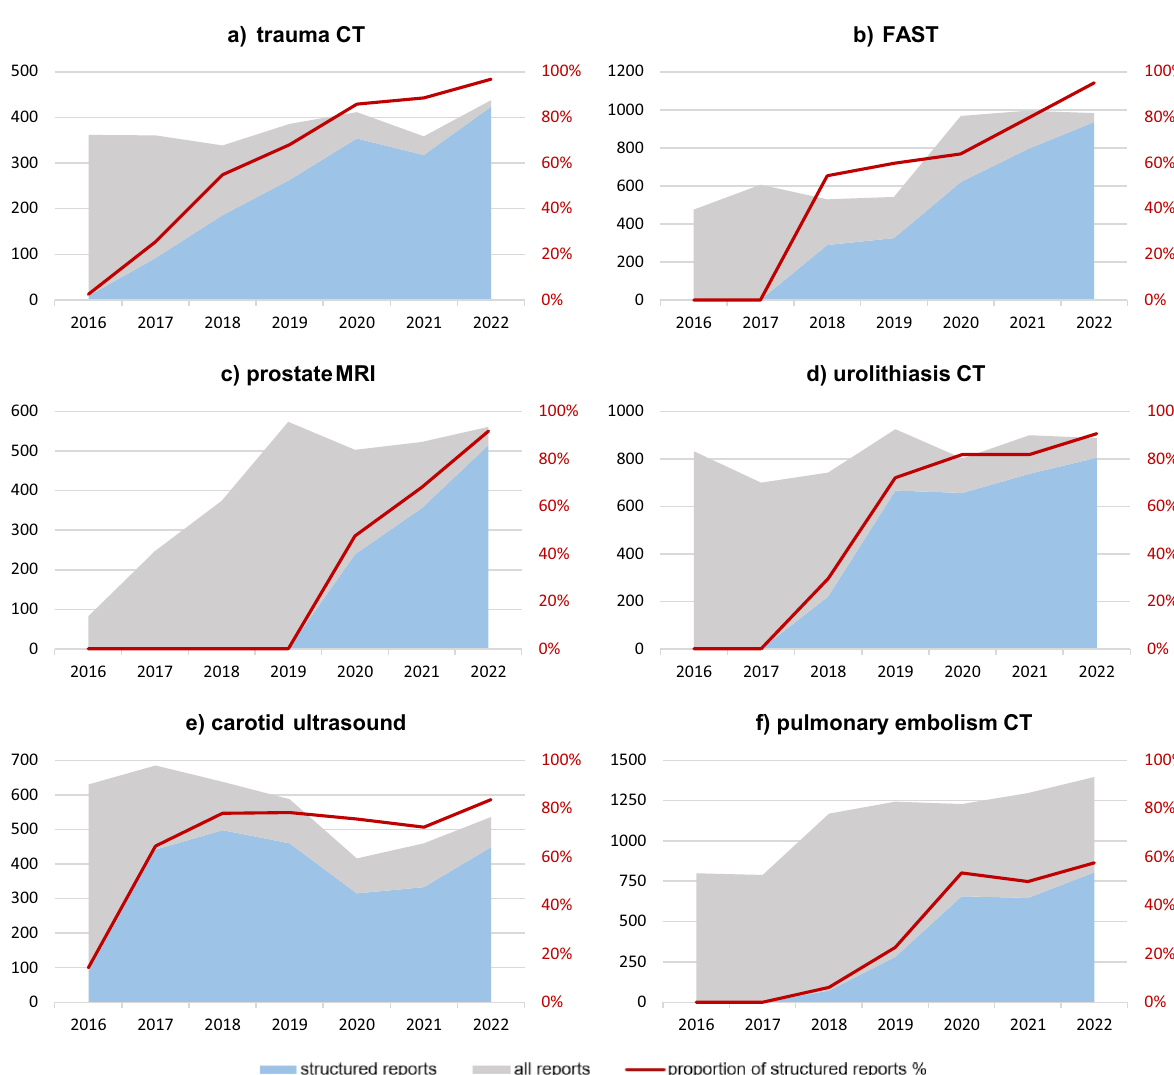
Fig. 3 Absolute numbers of all radiological reports (grey) and structured reports (blue) as well as the proportion of structured reports (red) over a 7-year period, shown for ( a ) trauma CT, ( b ) focussed assessment with ultrasound in trauma (FAST), ( c ) prostate MRI, ( d ) urolithiasis CT, ( e ) carotid ultrasound, and ( f ) pulmonary embolism